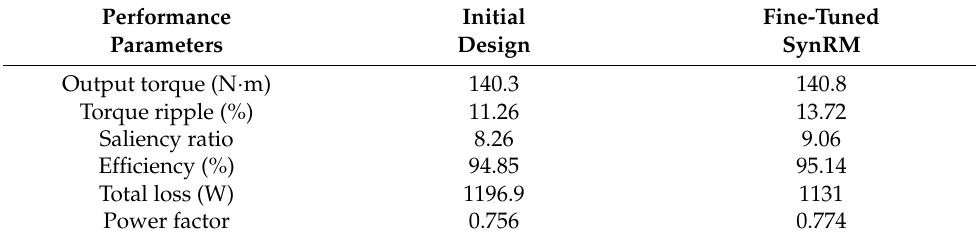
Table 9. Comparison of Finite Elementally analyzed SynRMs.